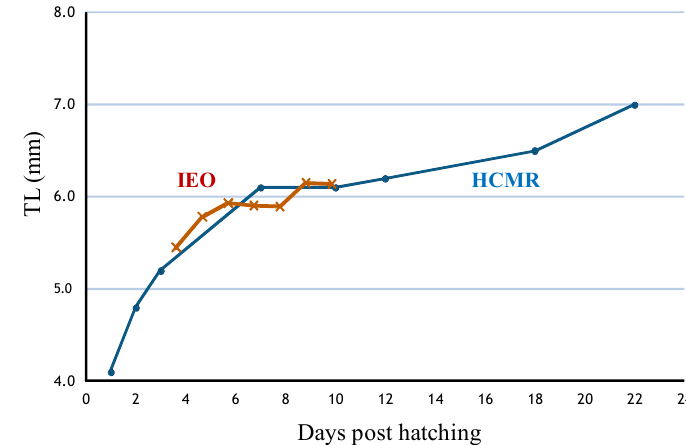
Figure 8. Total length curves (TL, mm) for Instituto Español de Oceanografía-IEO (11 dph) and Hellenic Center for Marine Research-HCMR (22 dph) larvae.